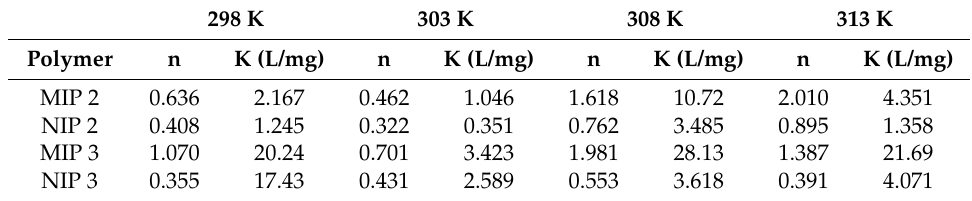
Table 5. Parameters of the Freundlich linearisation isotherms for the retention of PG with MIPs and NIPs. 298 K 303 K 308 K 313 K Polymer n